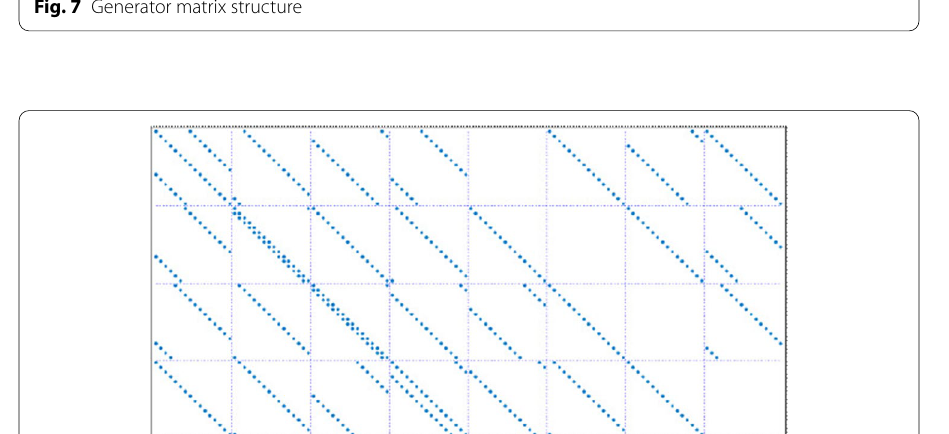
Fig. 8 Scatter chart for the parity check matrix H of the LDPC(128, 64) code